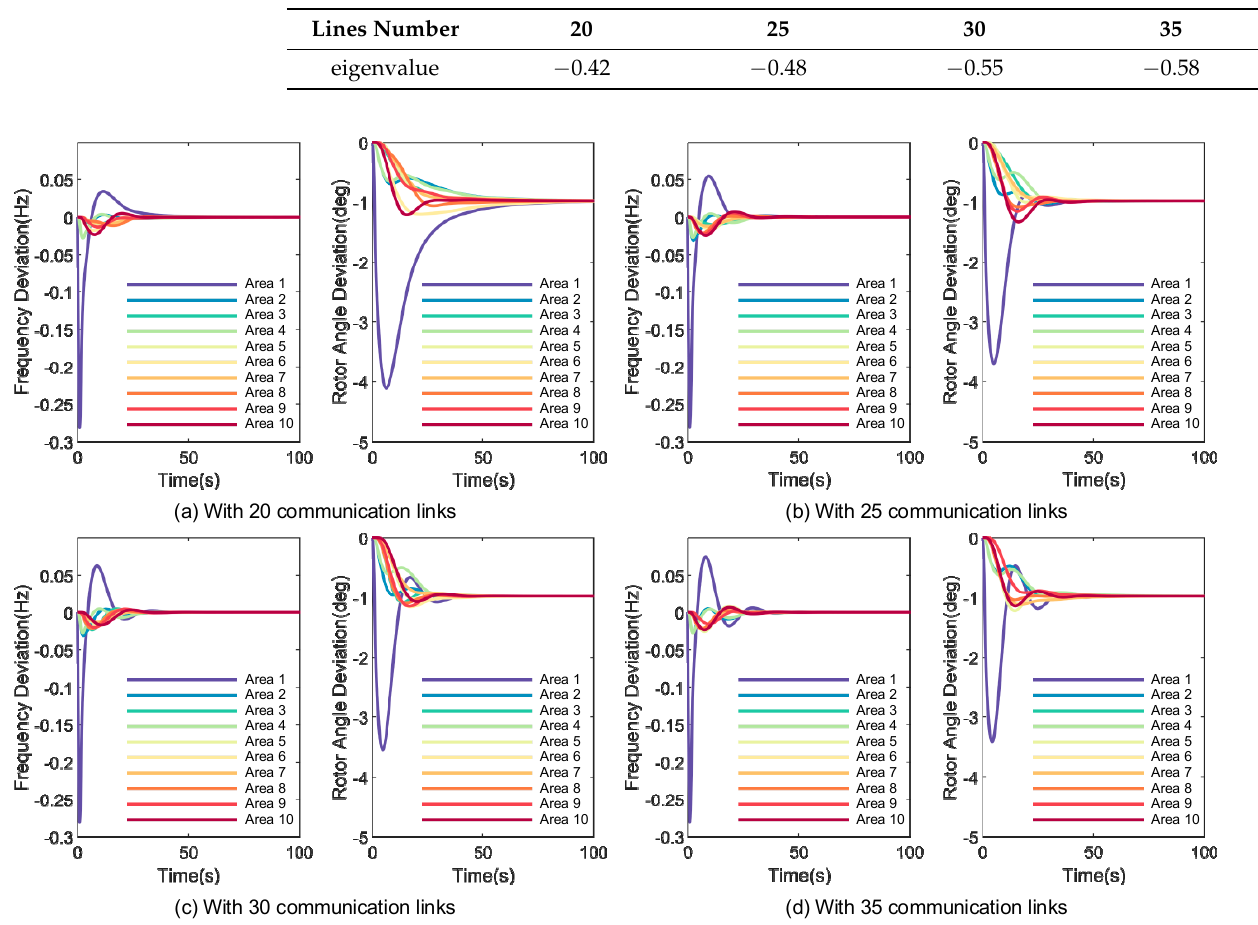
Table 1. Eigenvalue of the systems with 20, 25, 30 and 35 lines. Lines Number